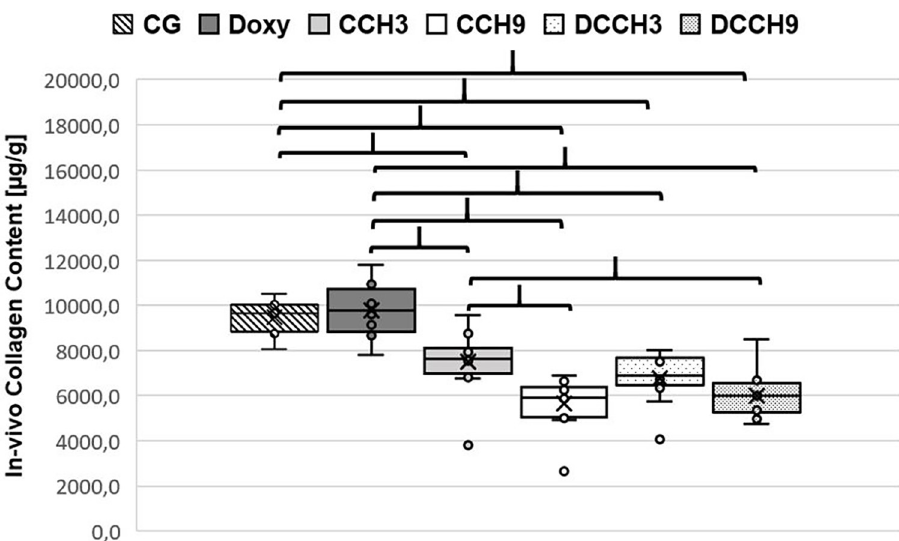
Fig 9. Results of in-vivo collagen quantification. Mean values (X) are graphed on a box plot and individual data points are shown. Brackets indicate statistically significant differences (p < 0.0083). Group size: n = 12.